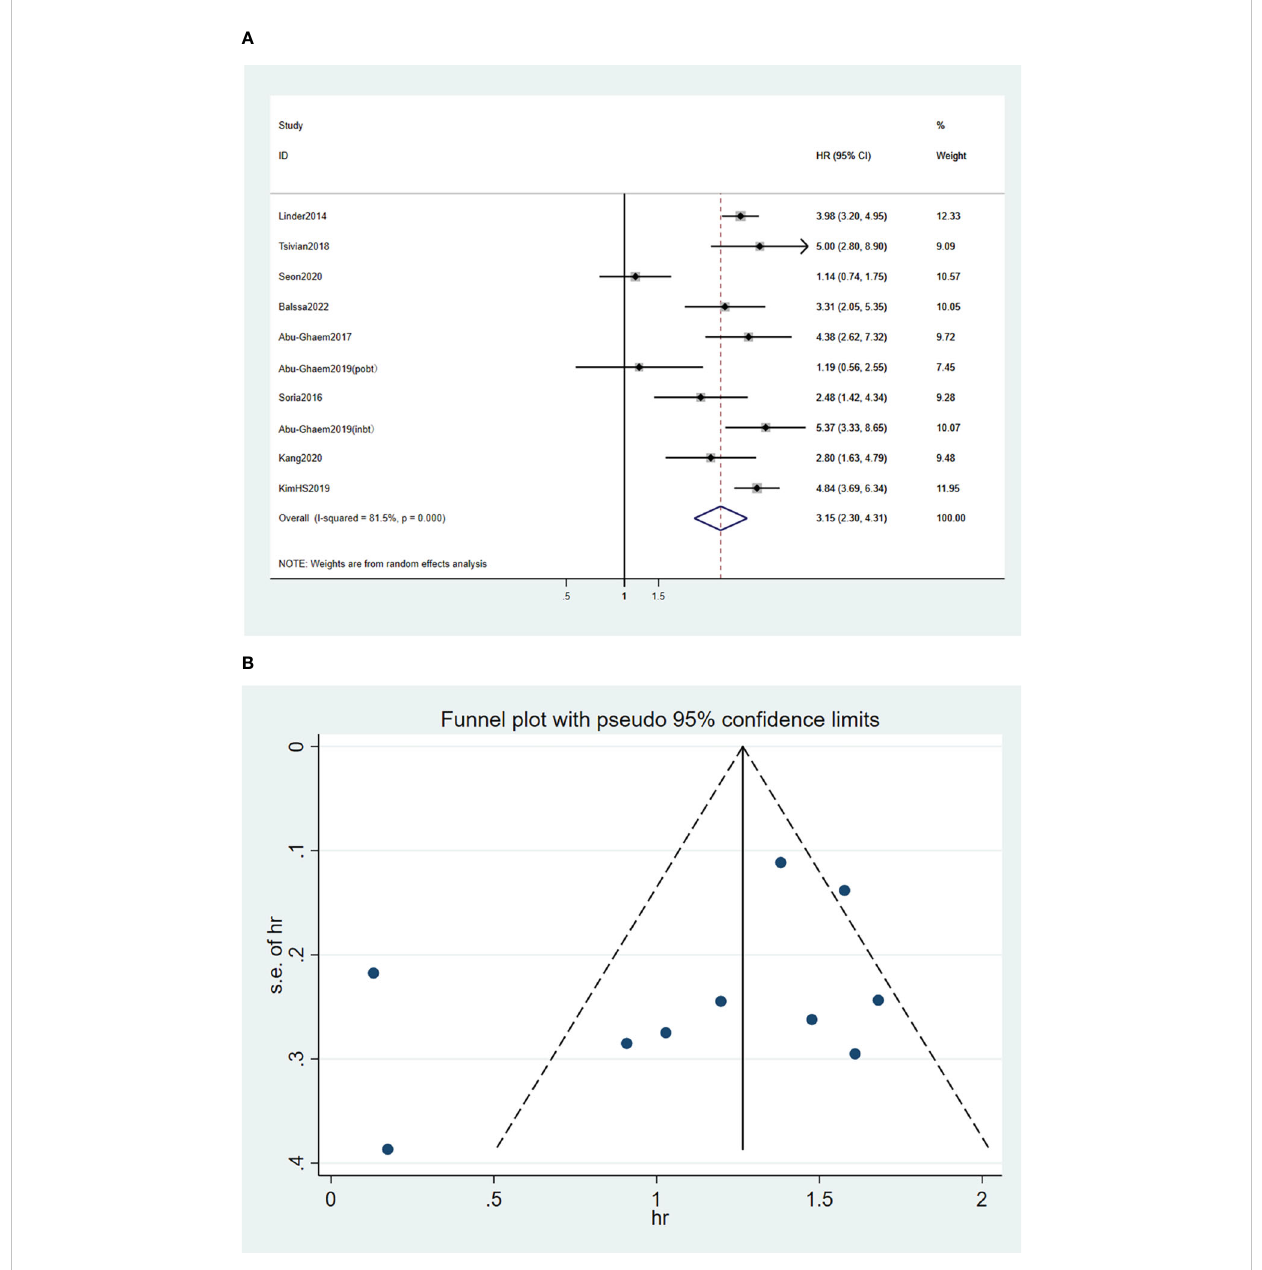
FIGURE 4 Forest plot (A) and funnel plot (B) depicting the association between PBT and cancer-speci fi c survival. HR values greater than 1 indicate that the intervention is detrimental to survival, implying that PBT was associated with poorer